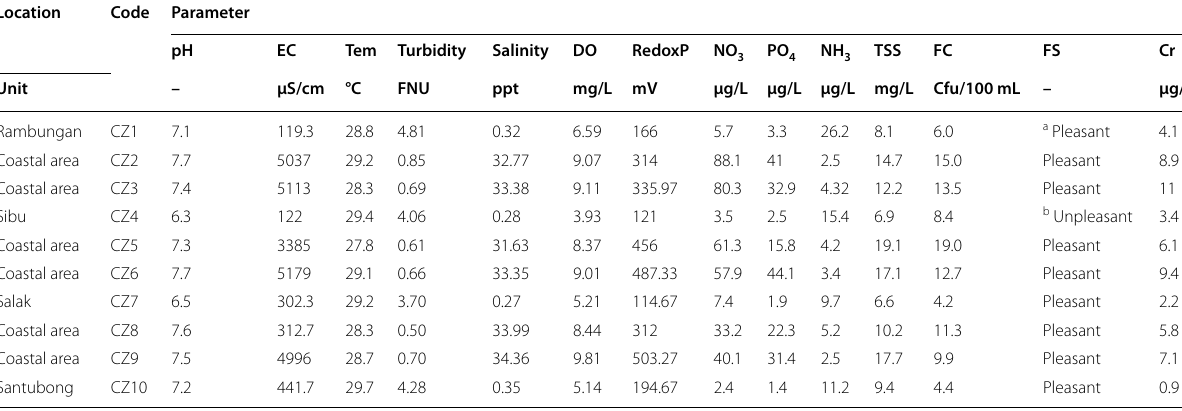
EC stands for Electrical Conductivity, Tem represents Temperature, DO stands for Dissolved Oxygen, TSS stands for Total Suspended Solids, FC represents Faecal Coliform, and FS stands for Float Solids